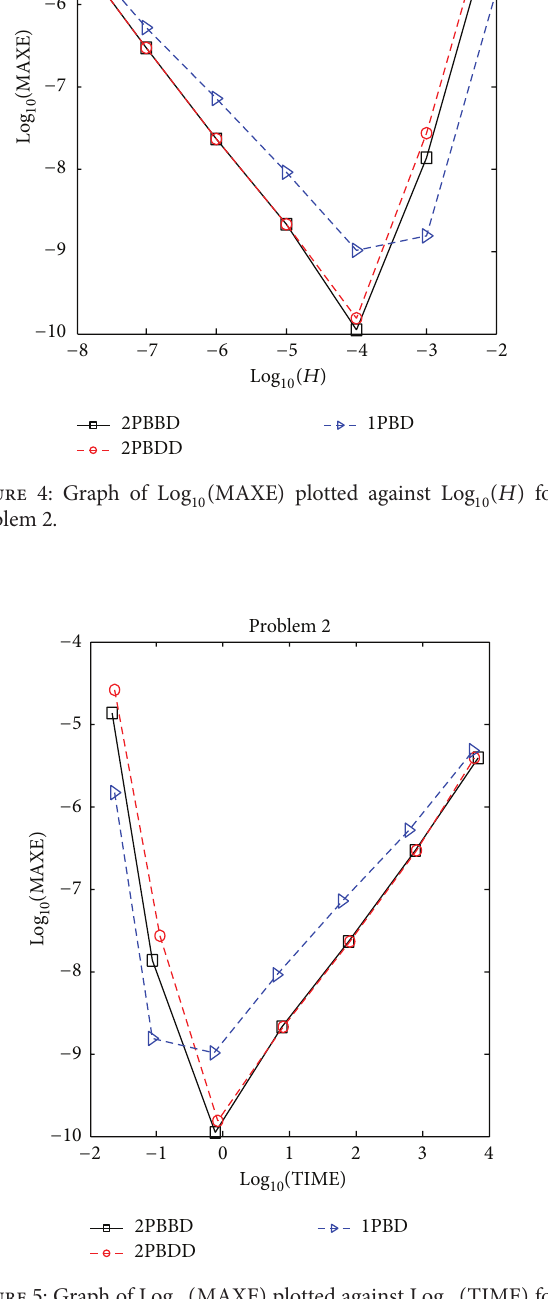
Figure 5: Graph of Log 10 ( MAXE ) plotted against Log 10 ( TIME ) for Problem 2.